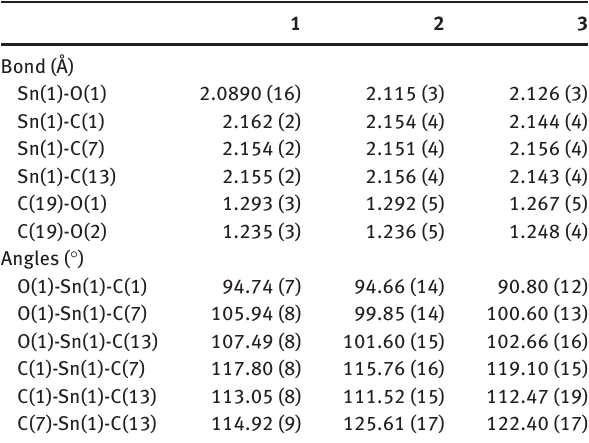
Table 1: Selected bond lengths (Å) and angles ( ° ) for 1–3 .